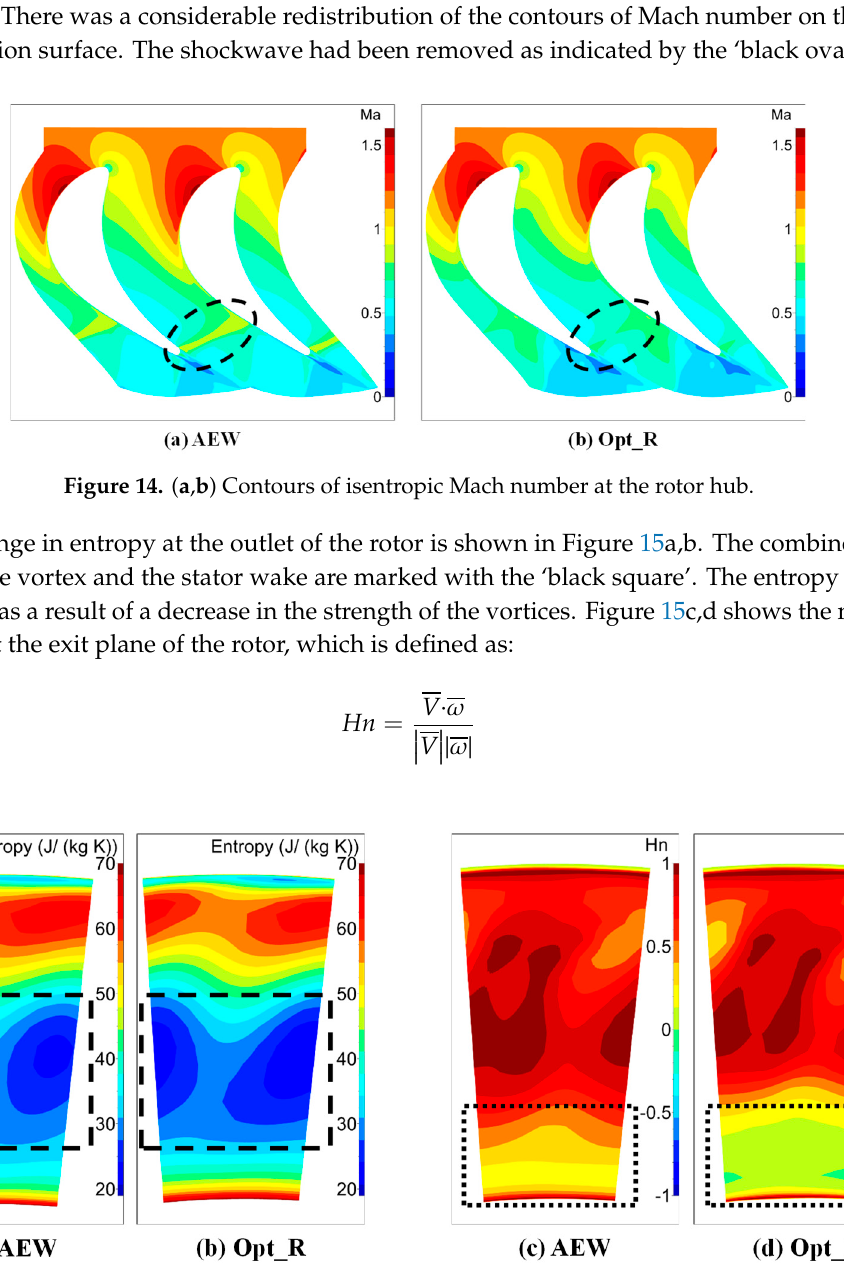
Figure 16. ( a – d ) Comparisons of contours of entropy and helicity at plane 3. The distribution of the static pressure on the suction surfaces of the stator and rotor along with the limiting streamlines are also shown in Figure 17. Inspecting the left figure, a distinct loss source in the form of corner vortex was clearly predicted and distinguished by the separation line. After the optimization, Opt_S, the trailing edge separation line and the corner vortex vanished completely. Moreover, the static pressure near the trailing edge of the stator increased, which was a typical indication that the profile had been aft-loaded. Similarly, the static pressure on the rotor suction surface decreased, especially from the leading edge to the mid chord. This helped to remove the separation line which was running from the rotor hub towards the midspan, as shown in Figure 17c.